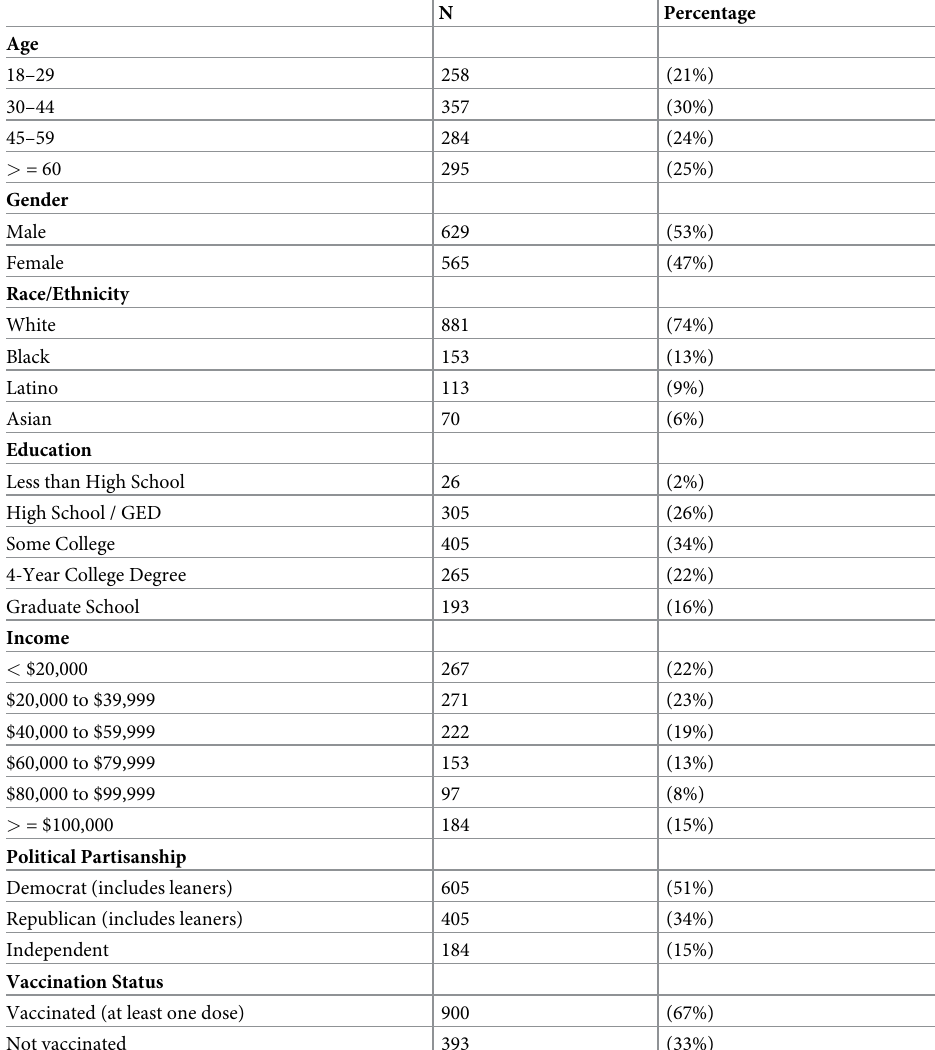
Table 1. Survey sample